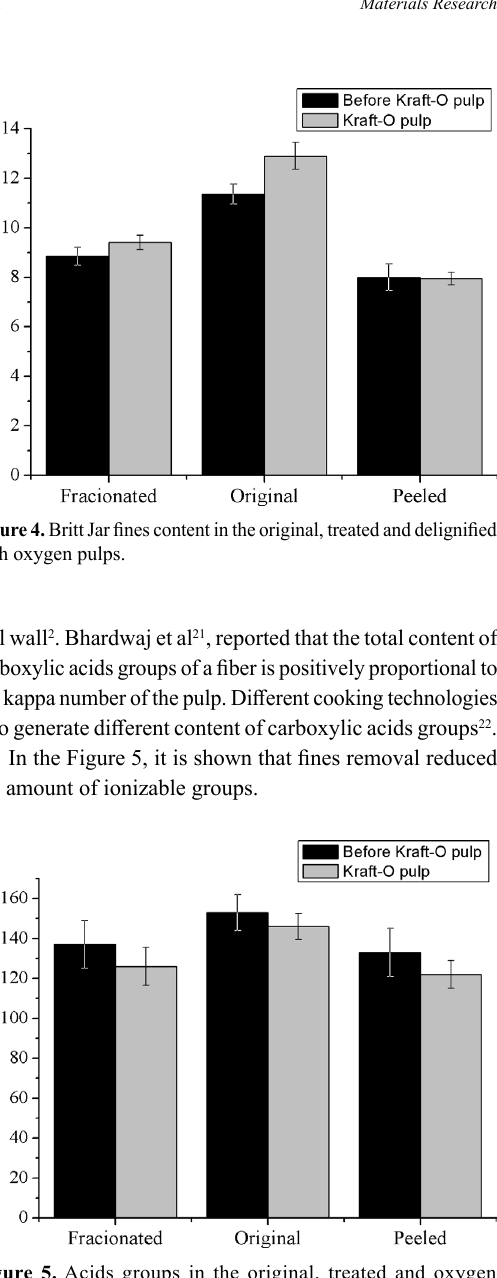
Figure 5. Acids groups in the original, treated and oxygen delignified